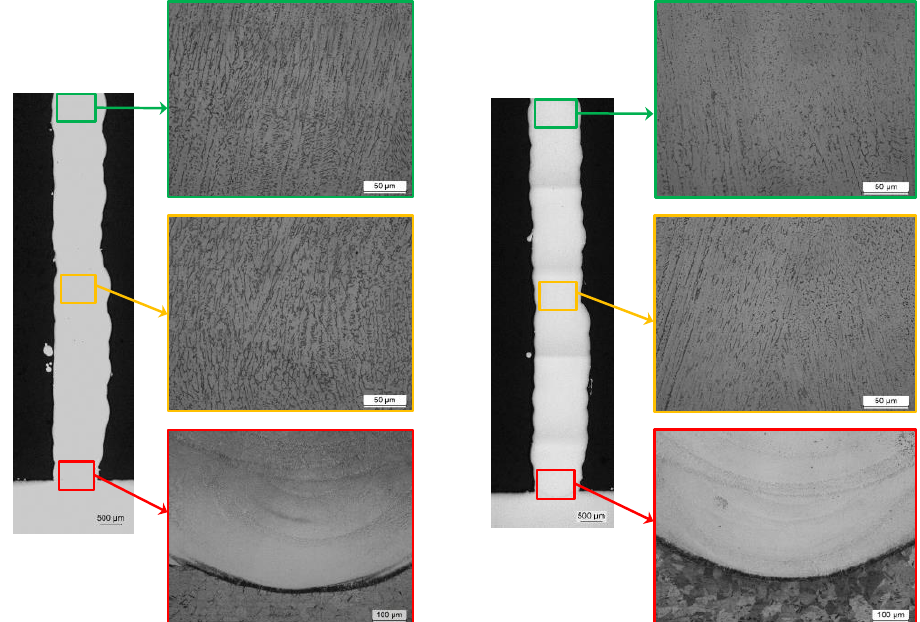
Figure 12. Photomicrographs by LOM of the walls made with SS316L. Sample 1 (e = 0.40, left ) and Sample 2 (e = 0.04, right ). Different study areas: Interface with the substrate (200X below), at 5 mm wall height (500X center) and 10 mm wall height (500X above).